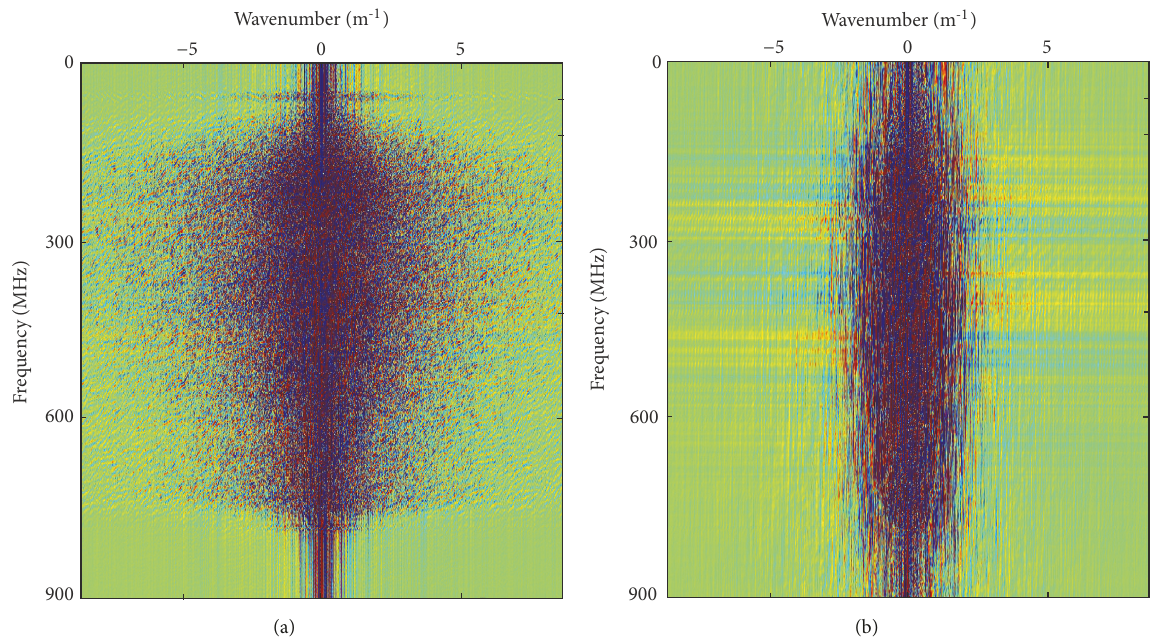
Figure 11: The comparison of f - k spectrum. (a) LPR CH-2 data. (b) Adaptive f-x EMD